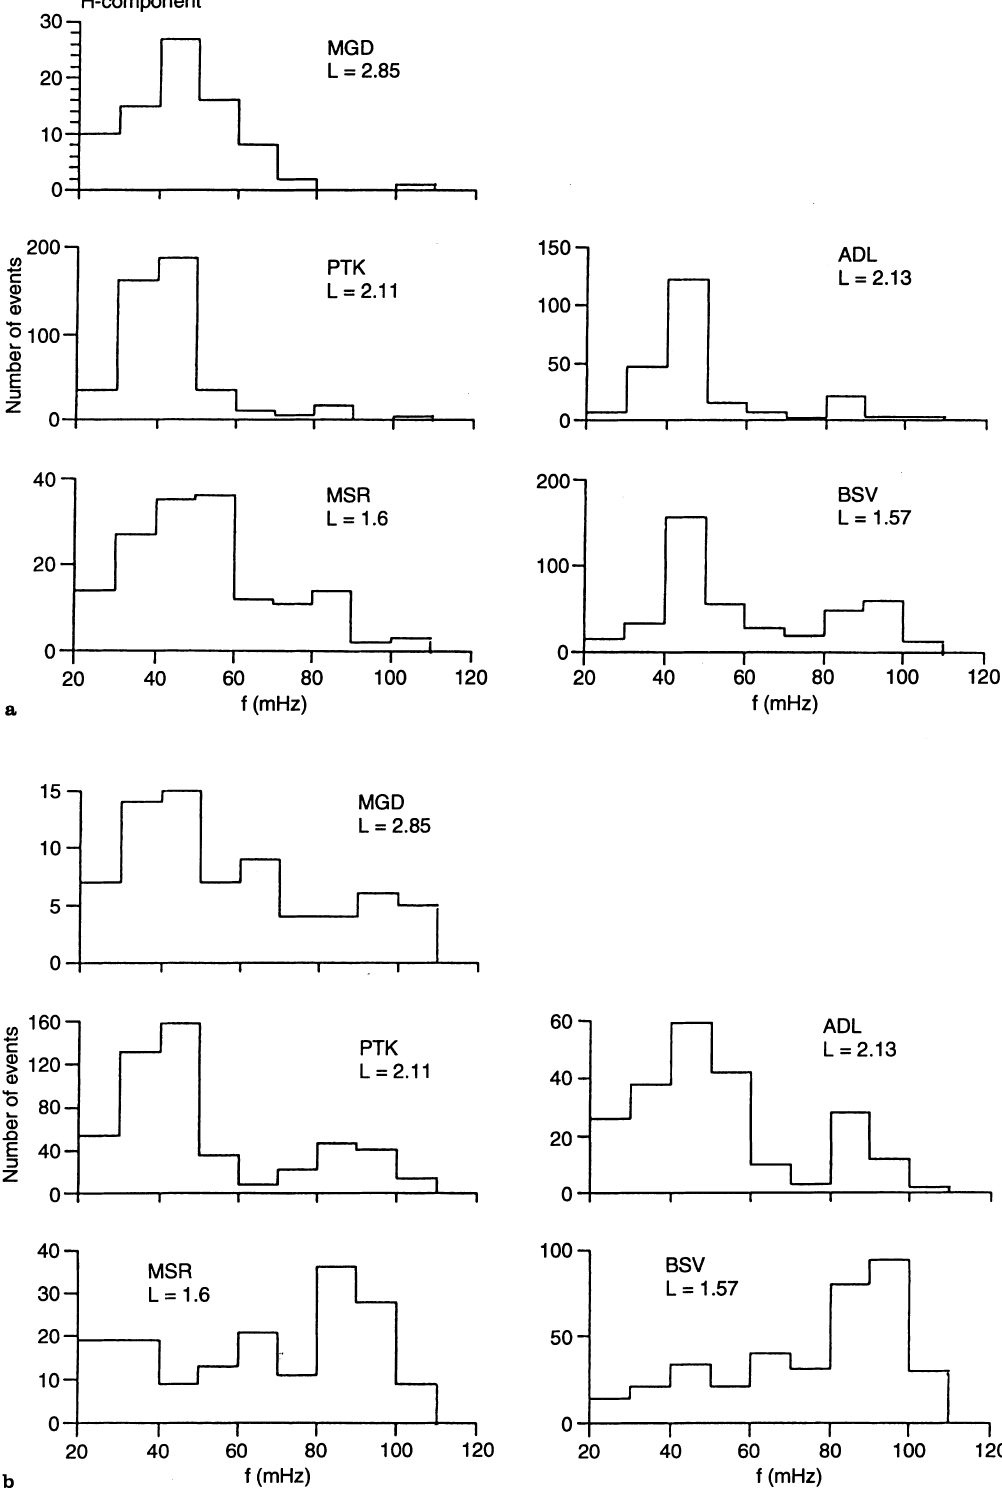
Fig. 12a,b. Histograms N (cid:133) f (cid:134) of number of intervals with maxima of H (cid:133) f (cid:134) ( upper ) and the H (cid:133) f (cid:134) = D (cid:133) f (cid:134) ratio ( lower ) at a frequency f for the Pc3 pulsations in September–October,